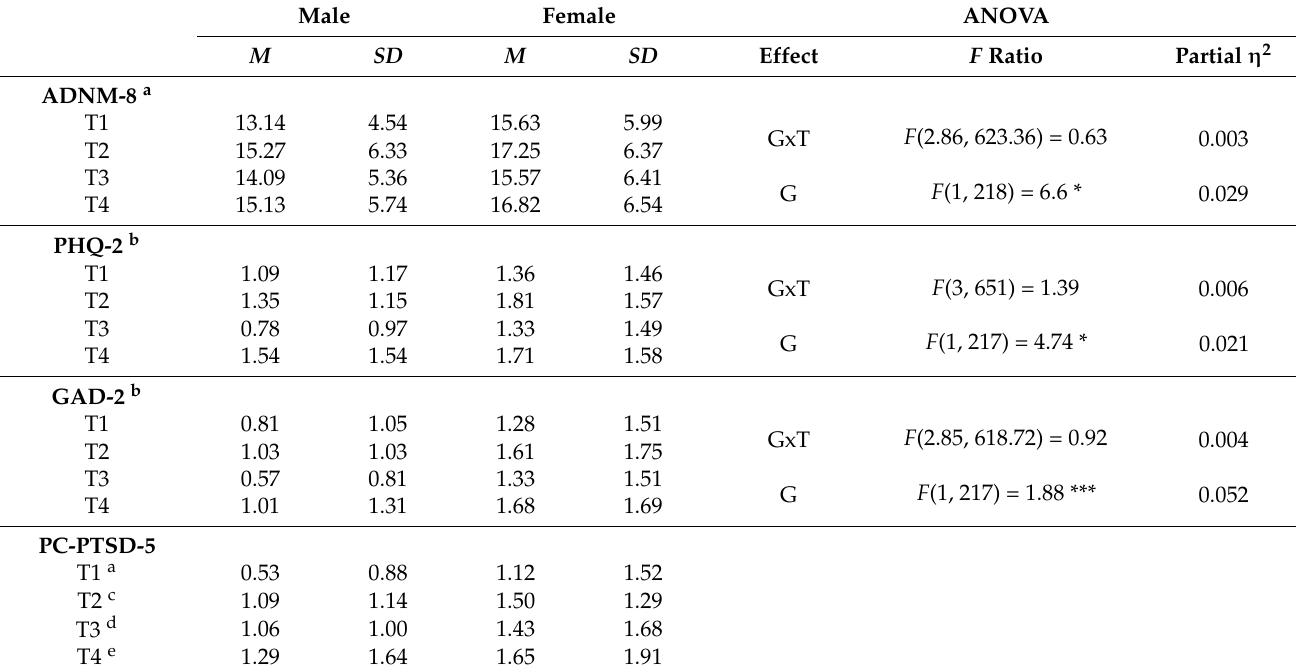
Table 6. Descriptive statistics and two-way ANOVA statistics of mental health outcomes for males and